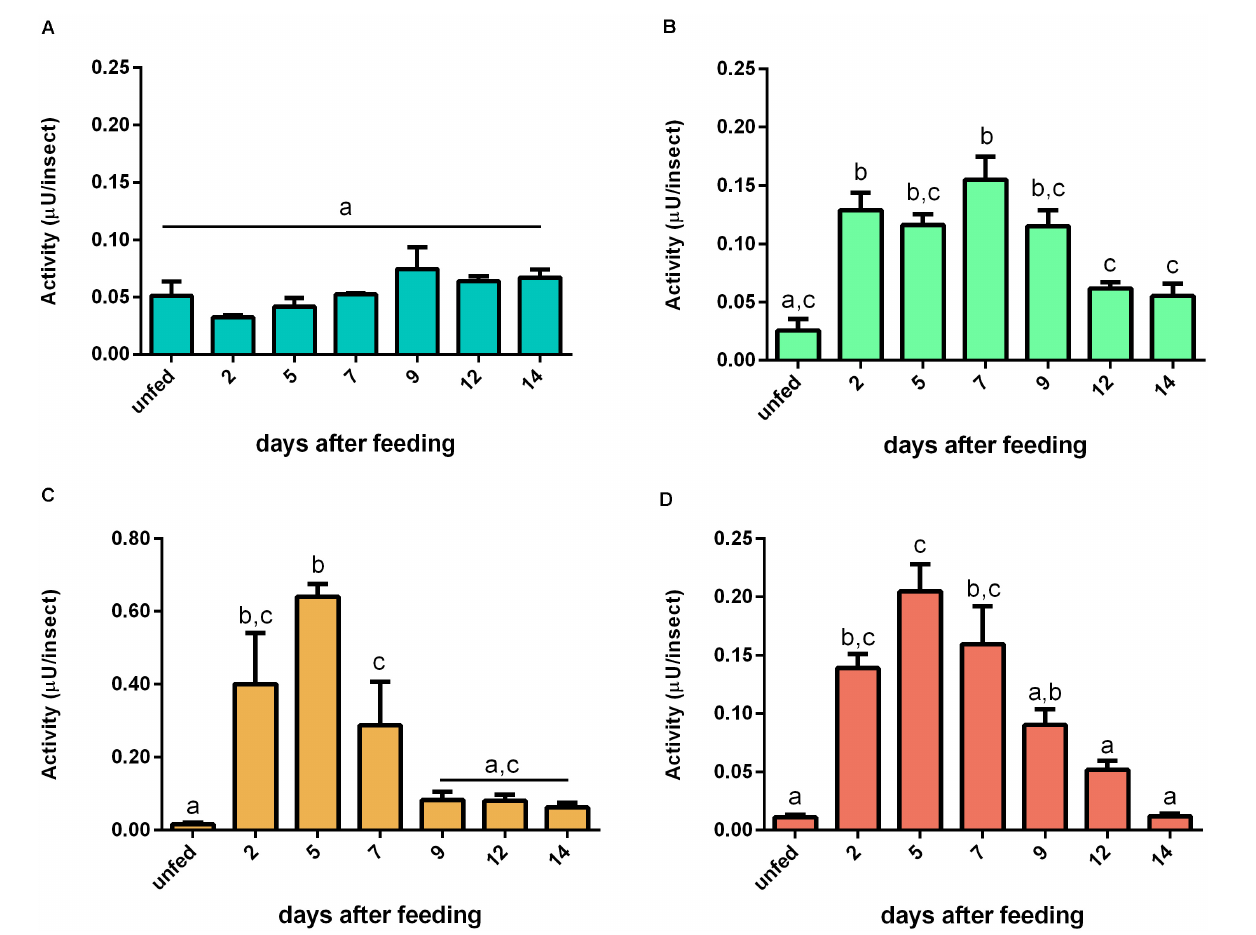
FIGURE 9 | Activity ( µ U per insect) against bovine serum albumin in the different digestive compartment tissues and luminal contents of Rhodnius prolixus male adults, unfed and at 2, 5, 7, 9, 12, and 14 daf on defibrinated rabbit blood, assayed in 0.2 M citrate-phosphate buffer, pH 5.5. (A) Anterior midgut tissues. (B) Posterior midgut tissues. (C) Anterior midgut contents. (D) Posterior midgut contents. Figures are means ± SEM from three different homogenate samples obtained from pools of two insects each. In a dataset, groups with the same superscript letter are not significantly different ( p > 0.05). Statistical analysis consisted of ordinary one-way ANOVA with Tukey’s multiple-comparisons